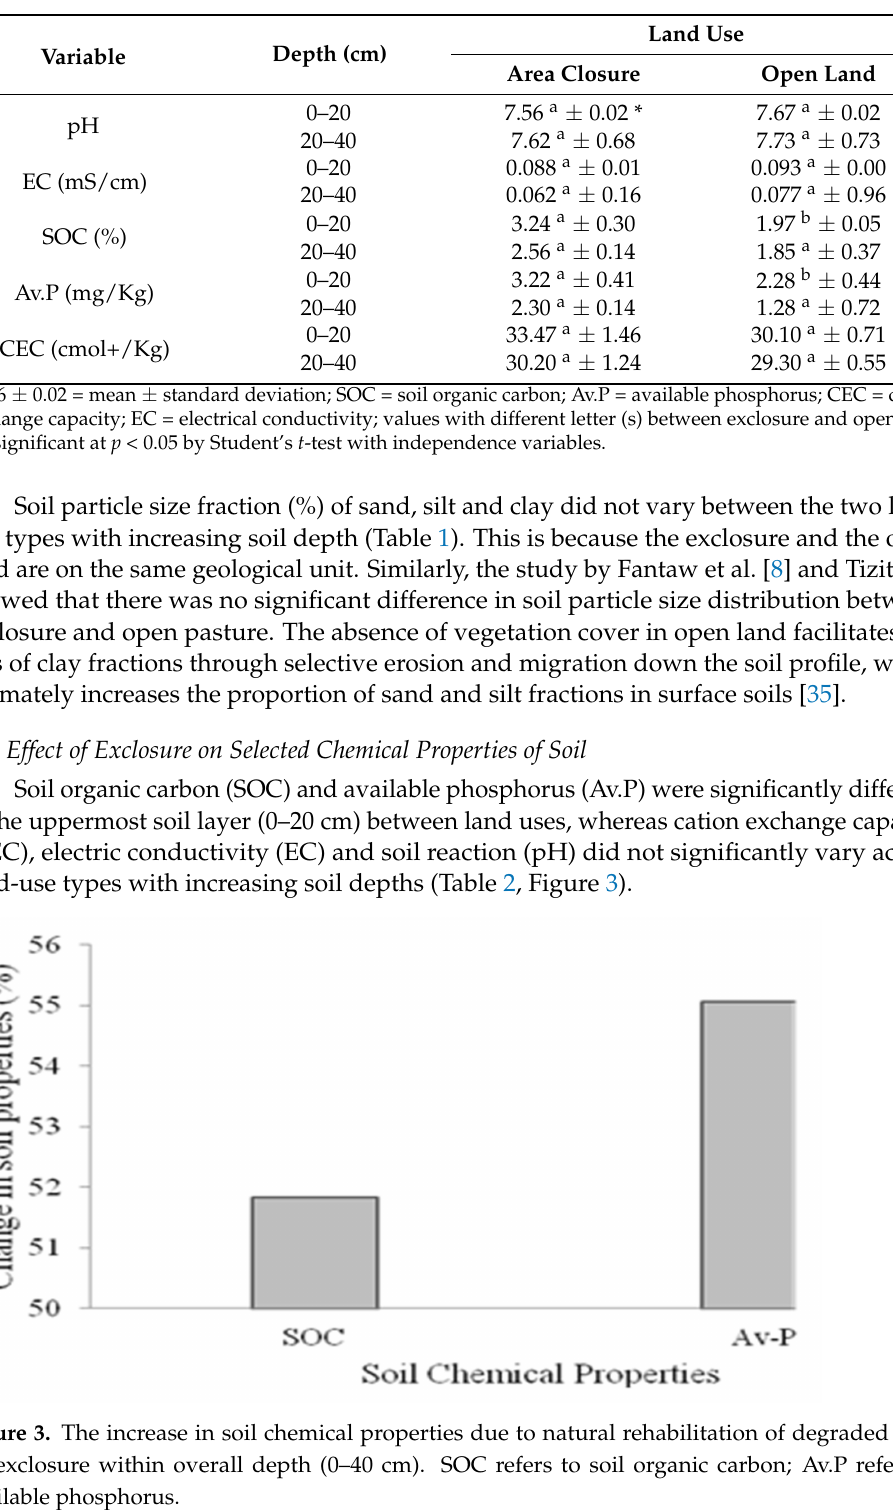
Table 2. Soil chemical properties of the area closure and open land.